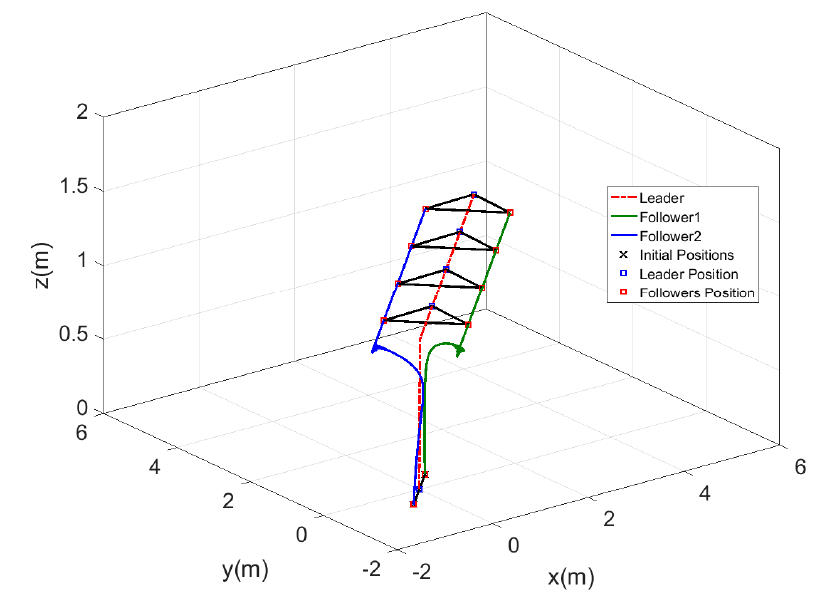
Figure 14. Three-dimensional view of fixed formation tracking ramp trajectory.